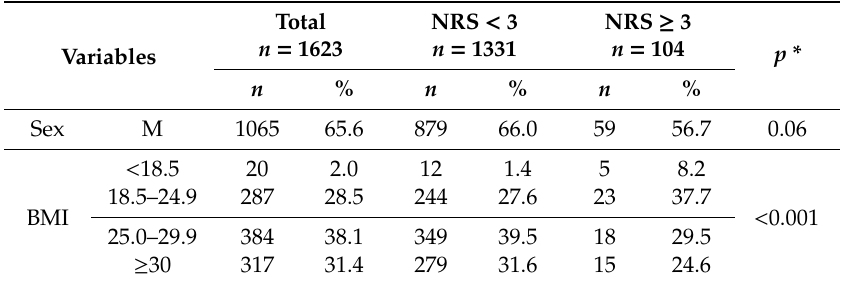
Table 3. The comparison of evaluated parameters with the